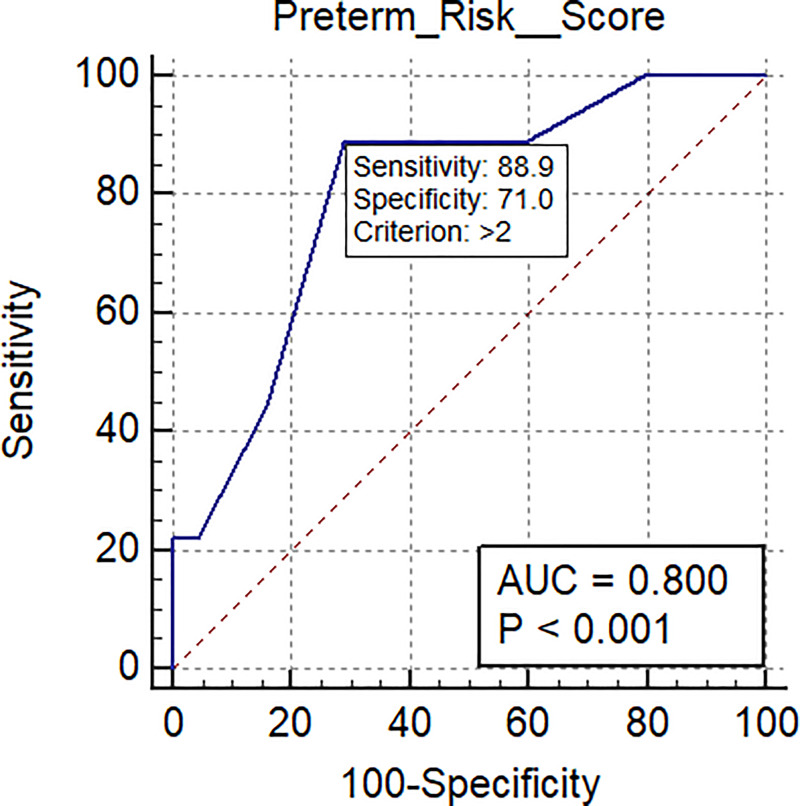
The AUC-ROC score for spontaneous preterm birth for the full first trimester time range (6.6–12.9 weeks gestational age; mean 10.0 ±1.8 weeks) was 0.80 (95% CI: 0.69 to 0.88; p<0.001) in the validation set.